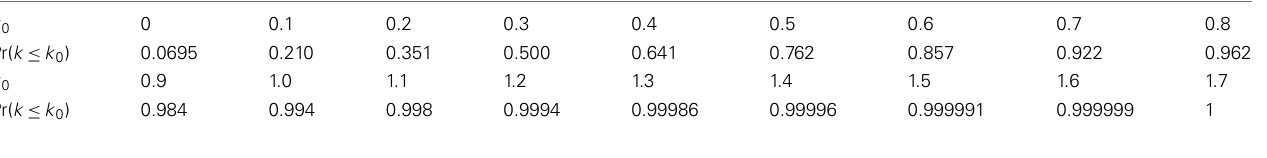
Table 5 | k -Value cdf for cancer cells in a clinically detectable